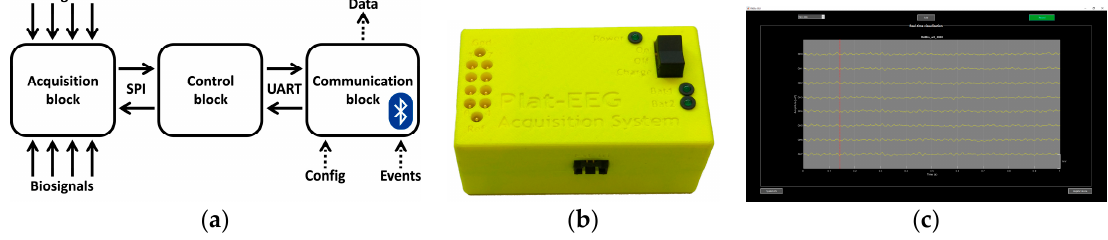
Figure 1. RABio w8 system: ( a ) Diagram of the electronics; ( b ) Picture of the hardware; ( c ) Screenshot of the graphical user interface (GUI).